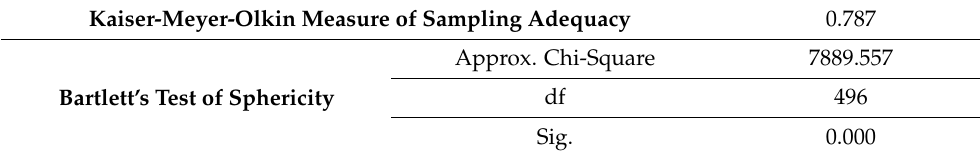
Table 2. Kaiser-Meyer-Olkin (KMO) and Bartlett’s Test